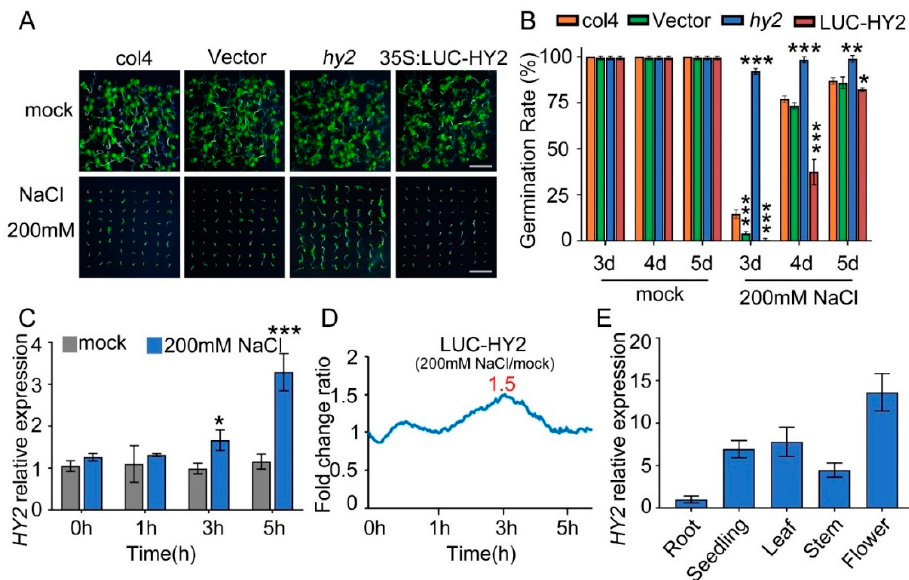
Figure 1. NaCl sensitivity of hy2 mutant and HY2 -overexpressing lines. ( A ) Phenotypic comparison. Col4, LUC - vector , hy2 mutant, and LUC–HY2 overexpression lines were sown, respectively, on 1/2 MS medium (as mock) or 1/2 MS medium containing indicated concentrations of 200 mM NaCl for 4 d. Scare bar: 1 cm. ( B ) Seed germination assay. Seeds were transferred to 1/2 MS containing 200 mM NaCl, and then the seed germination rate was calculated at 3–5 d. Data are shown as mean ± SD ( n = 3). More than 64 seeds were measured in each replicate. ( C ) QPCR analysis of HY2 expression in 5-day-old col4 seedlings treated with or without 200 mM NaCl for 0–5 h. Data are shown as mean ± SD ( n = 3). ( D ) LUC signals in 5-day-old LUC–HY2 overexpression line seedlings treated with or without 200 mM NaCl. Signals were detected every 10 min, and the detecting period was 5 h. ( E ) QPCR analysis of HY2 expression in different tissues of Arabidopsis . Data are shown as mean ± SD ( n = 3). Asterisks in ( B , C ) indicate statistically significant differences compared with relevant col4 plants: * p < 0.05, ** p < 0.01, *** p < 0.001.